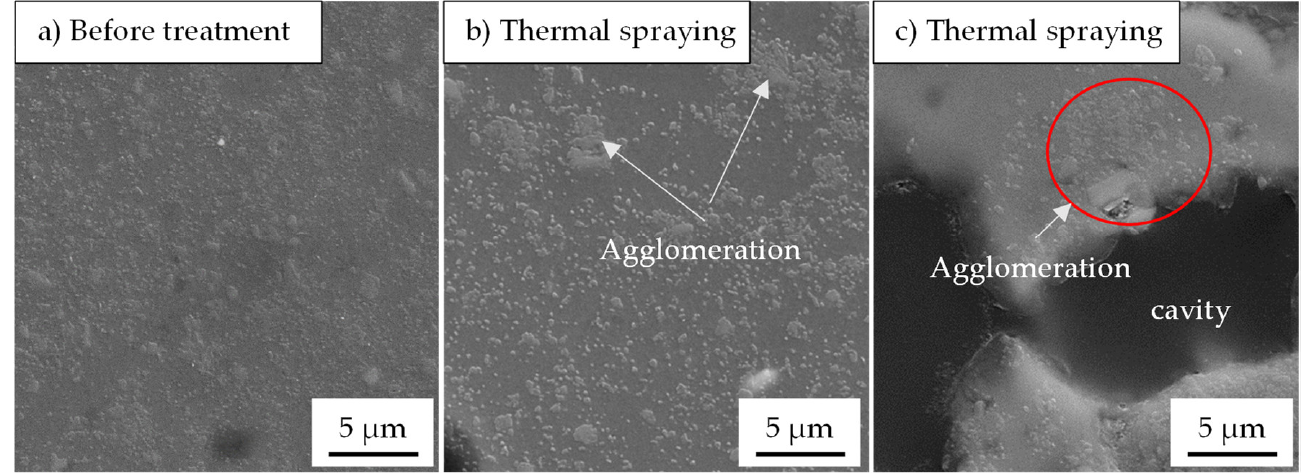
Figure 16. SE-SEM micrographs of the composite powders (AlSi10Mg + 5 vol% SiC) milled with menthol: ( a ) before treatment, ( b ), and ( c ) after thermal spraying showing the redistribution and agglomeration of SiC.